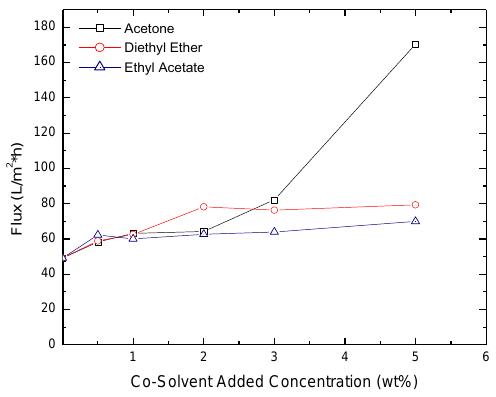
Figure 7. Flux of IPA through membranes formulated with acetone, diethyl ether and ethyl acetate added as co-solvents.